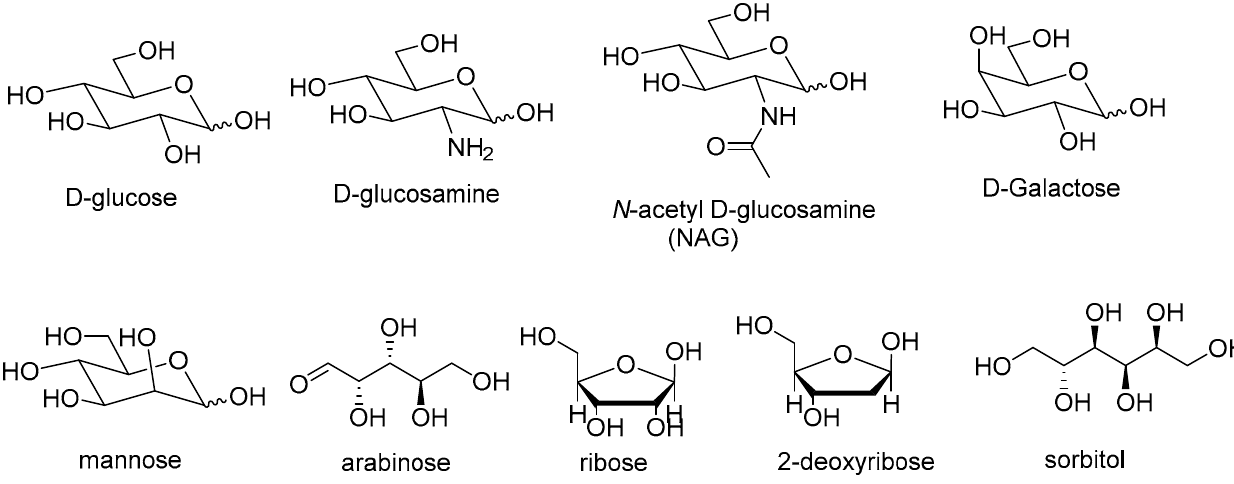
Figure 1. Structures of the sugar starting materials used often for designing low molecular weight gelators (LMWGs).